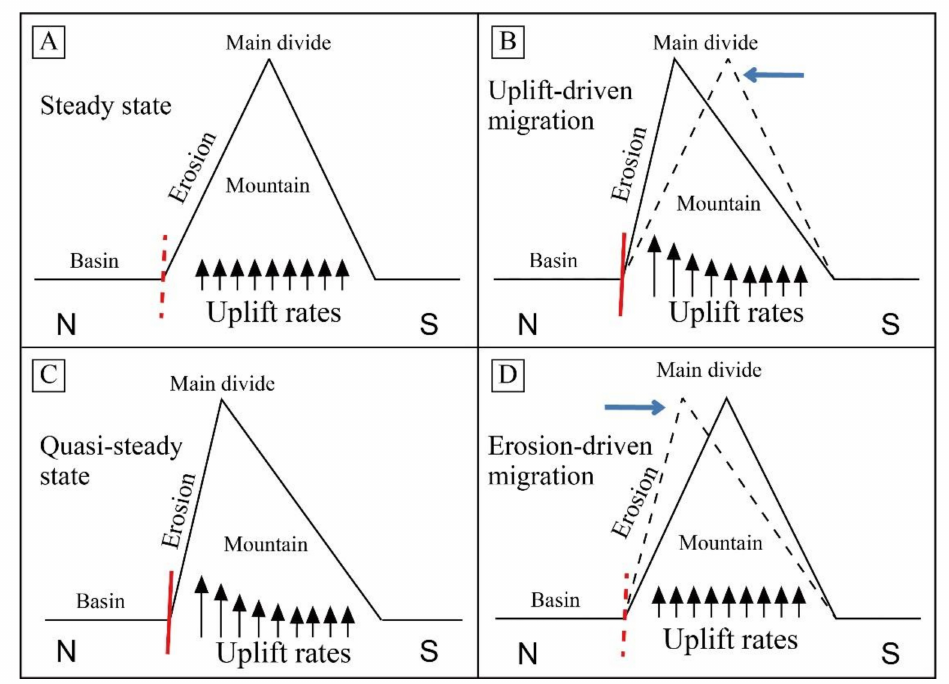
Figure 7. Schematic diagram of main divide migration. The red dotted lines represent that the fault is inactive, and the red lines show the active faults. The blue arrows show the divide migration direction. The black arrows show the uplift rate. ( A ) Steady state landscape without tectonic disturbance. Uplift and erosion balance each other. ( B ) The main divide is moving northward due to higher uplift rates on the northern range. Uplift outpaces the erosion. ( C ) The main divide reaches a quasi-steady state. ( D ) After the tectonic activity ceases, the main divide migrates back to its original location, and eventually reaches the steady state. It should be noted that there exist no scale in the Figure